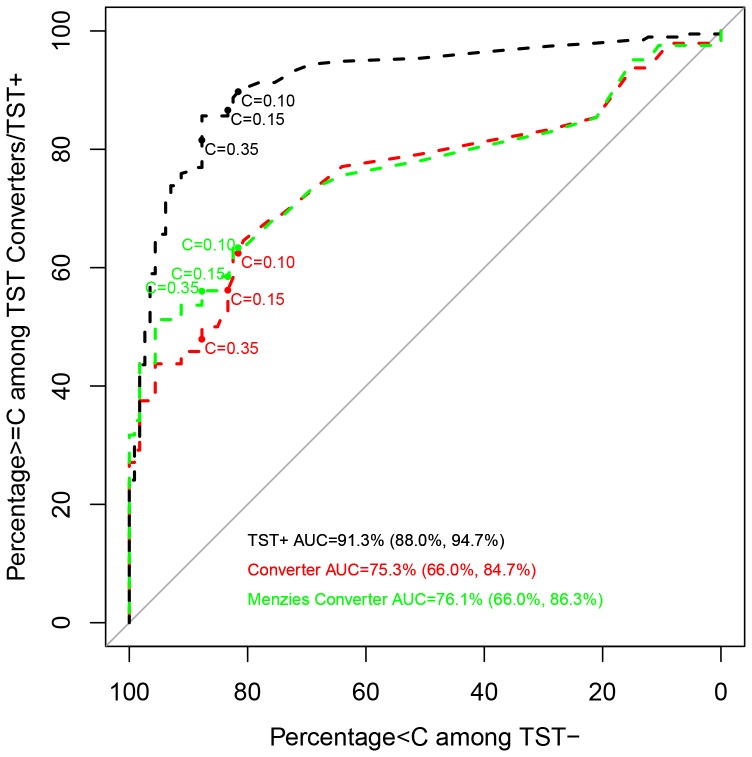
ROC curves for TBag − Nil.Statistics displayed on the curves are C = X: Y, Z, where X is the TB Ag − Nil (IU/ml) cutoff value for which IGRA would be declared positive. Y is Percentage of TST-negative (Specificity) that is below the cutoff and Z are the Percentage of TST-positive or TST converters at or above the cutoff (Sensitivity).